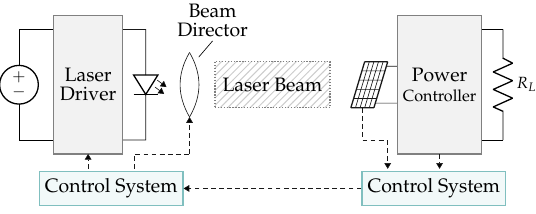
Figure 22. Schematic diagram of an HILPB system [49].